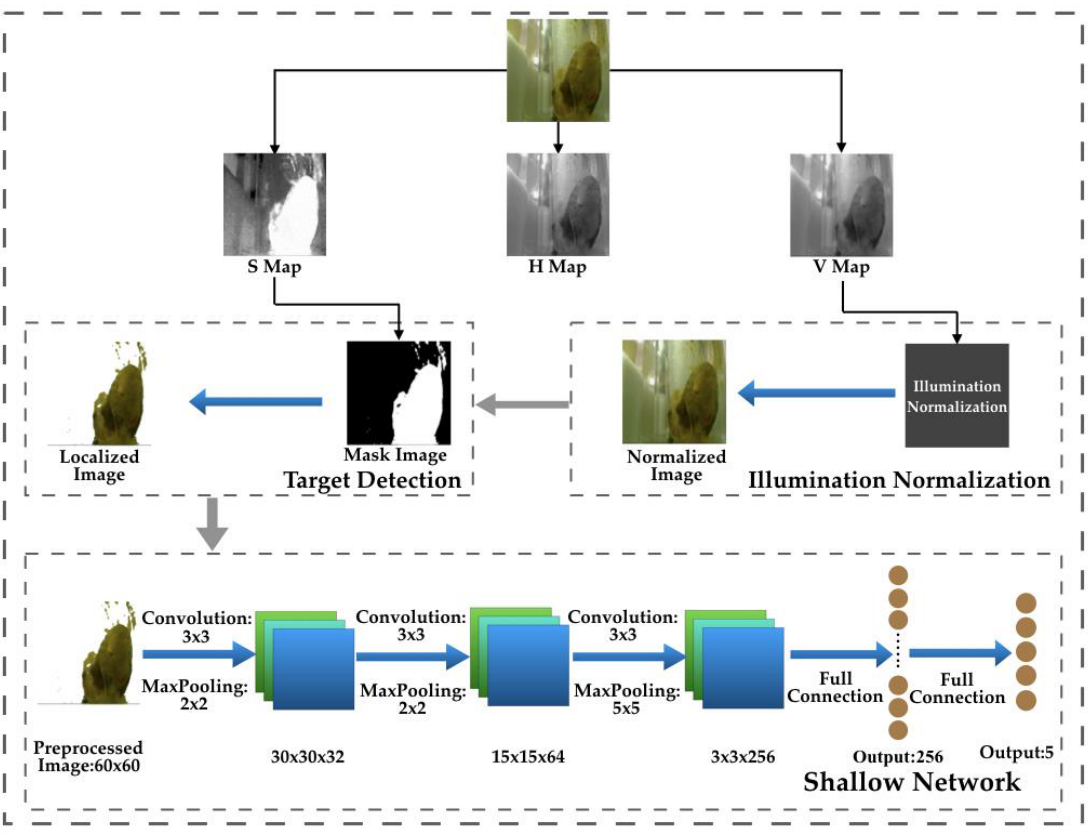
Figure 2. The framework of fecal trait examination.